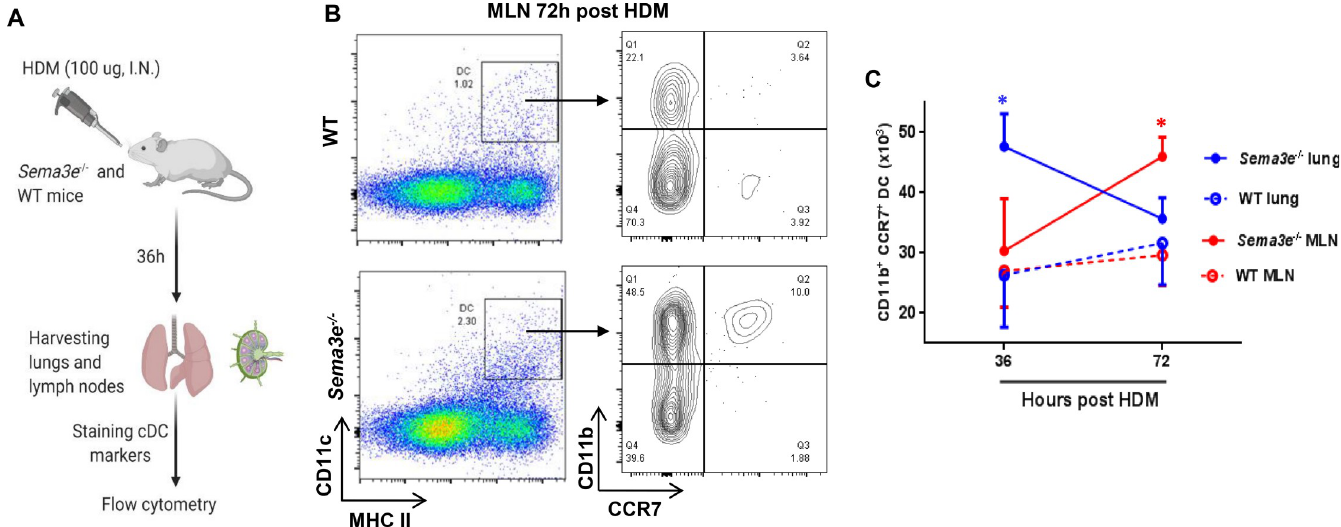
Fig 2. HDM sensitization induces upregulation of CCR7 in Sema3e -/- pulmonary dendritic cells. A schematic representation of in vivo model to induce HDM sensitization (A). CCR7 surface expression in CD11b + cDC from the lung and MLN was compared between Sema3e -/- and WT mice after 36 or 72h intranasal administration of HDM (B). Statistical comparison of CD11b + CCR7 + cDC from lungs or MLN between Sema3e -/- and WT mice 36 and 72h post-sensitization (n = 3–6 per group, � P < 0 . 05 ).